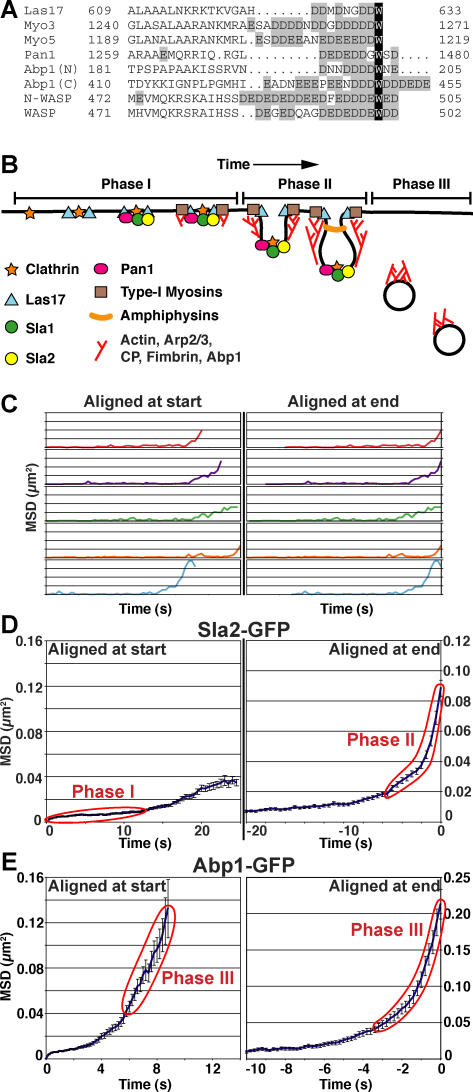
Acidic Domains of Arp2/3 Activators, Model of Actin Patch Assembly and MSD Examples(A) Alignment of acidic/DDW regions of S. cerevisiae Arp2/3 activators with the corresponding regions of human WASp and N-WASp. Acidic residues are highlighted with gray and the conserved tryptophan with black. Numbers are amino acid residues. The entire region shown here was removed in “Δacidic” strains.(B) Model of actin patch formation and movement, adapted from previous studies [23,24,33], are shown.(C) Examples of squared displacement plotted versus time for five individual patches, with the curves aligned at the start (left) or (right) end of patch lifetime. Such curves would then be averaged to generate MSD plots.(D) Typical MSD plots of wild-type patches labeled with Sla2-GFP generated by aligning individual curves at the start (left) or the end (right) of patch lifetime. On the left, the plot is truncated when half of the patches have disappeared, indicating the median lifetime. Phases I and II of patch movement are indicated.(E) Typical MSD plots of wild-type patches labeled with Abp1-GFP generated as in (D). Phase III patch movements are indicated.